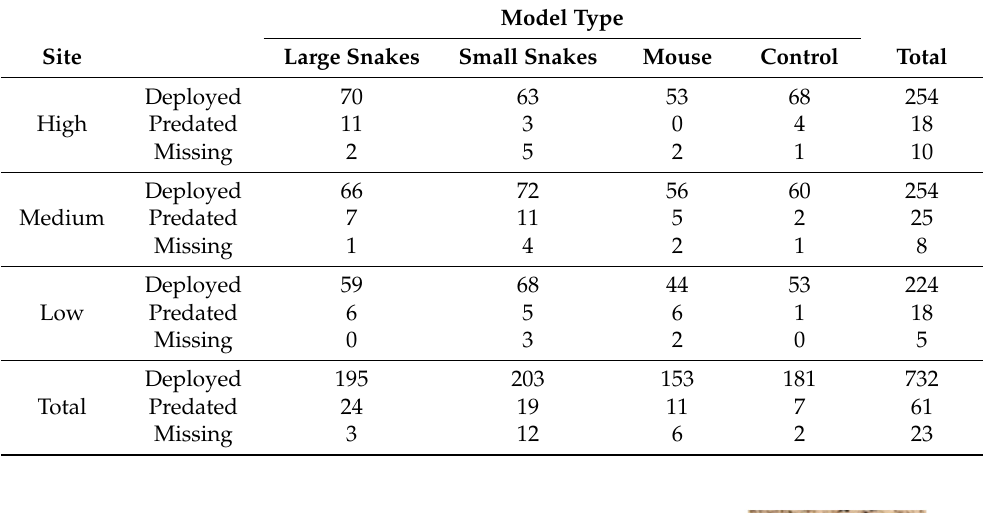
Table 2. Counts of urethane foam models, per type, with associated depredation events and missing counts, within each urbanization level in the Great Trinity Forest, Dallas, TX, USA.